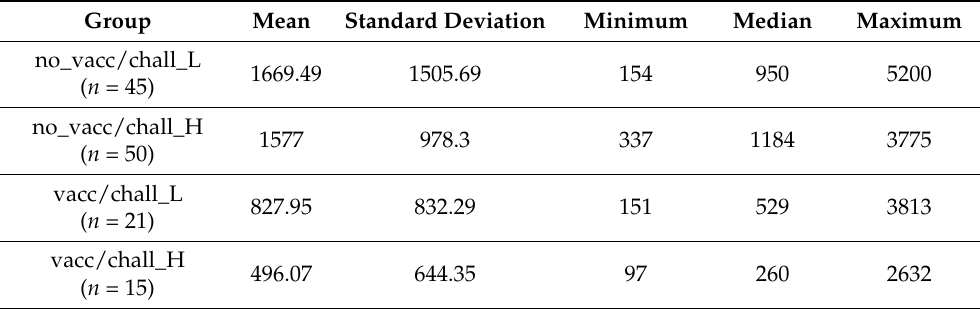
Table 2. Numerical summaries of total inflammatory cell count according to treatment groups.